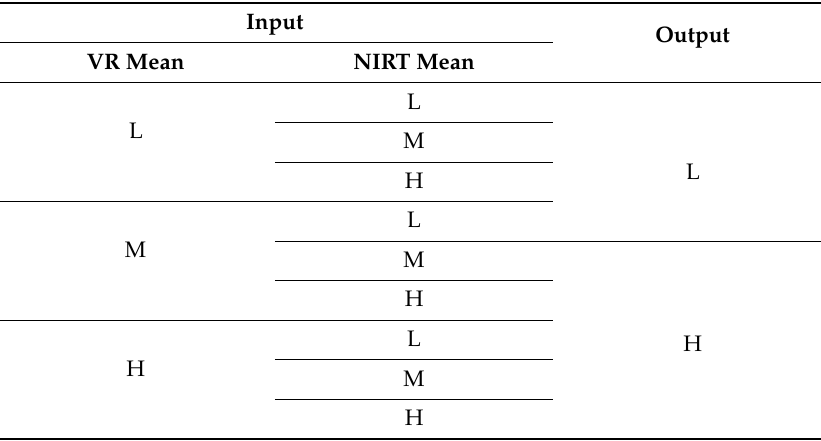
Table 1. Fuzzy rule table.